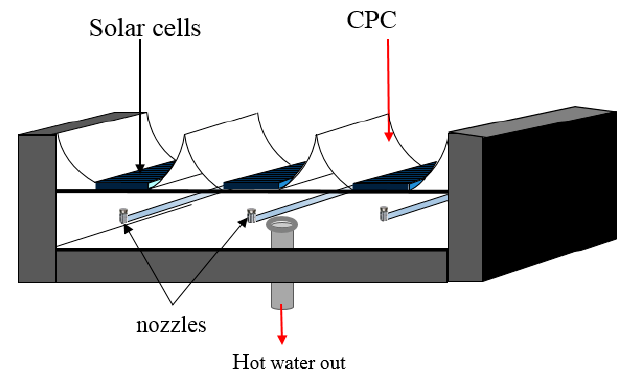
Figure 2. The schematic diagram of the PVT-CPC collector.